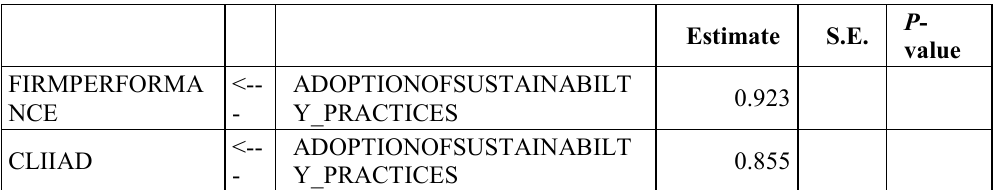
Table 2. Regression Weights: Group Number 1 – Default Model ( developed by the authors)